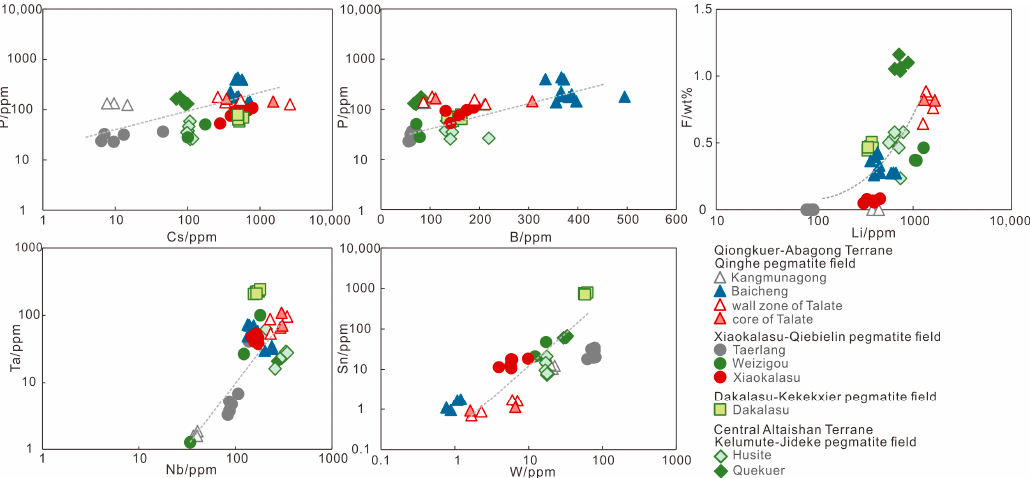
Figure 4. Plots of Fe + Mg + Mn, Al VI vs. Li apfu, Rb, Cs vs. Li and Rb vs. Cs contents showing substitutions among alkali elements.